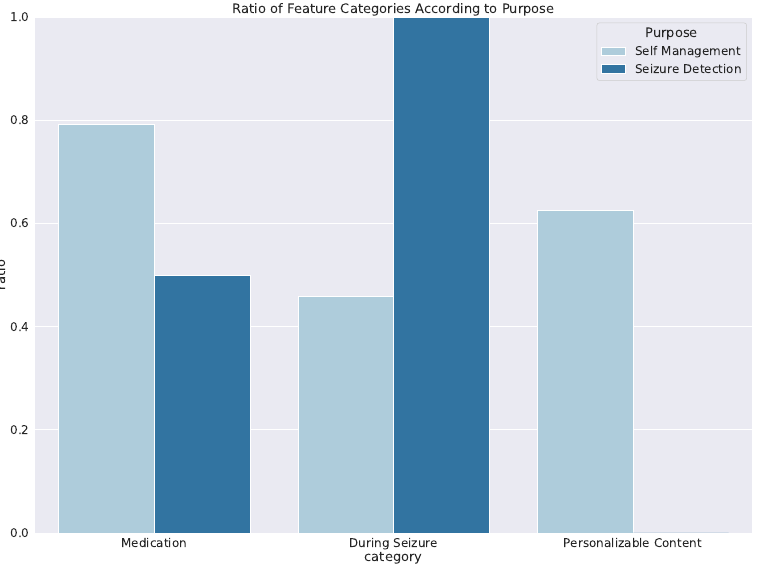
Figure 2. Ratio of apps that provide features related to medication, during seizure and personalisable content. All seizure detection apps contain during seizure, whilst the most prevalent category in self-management apps is